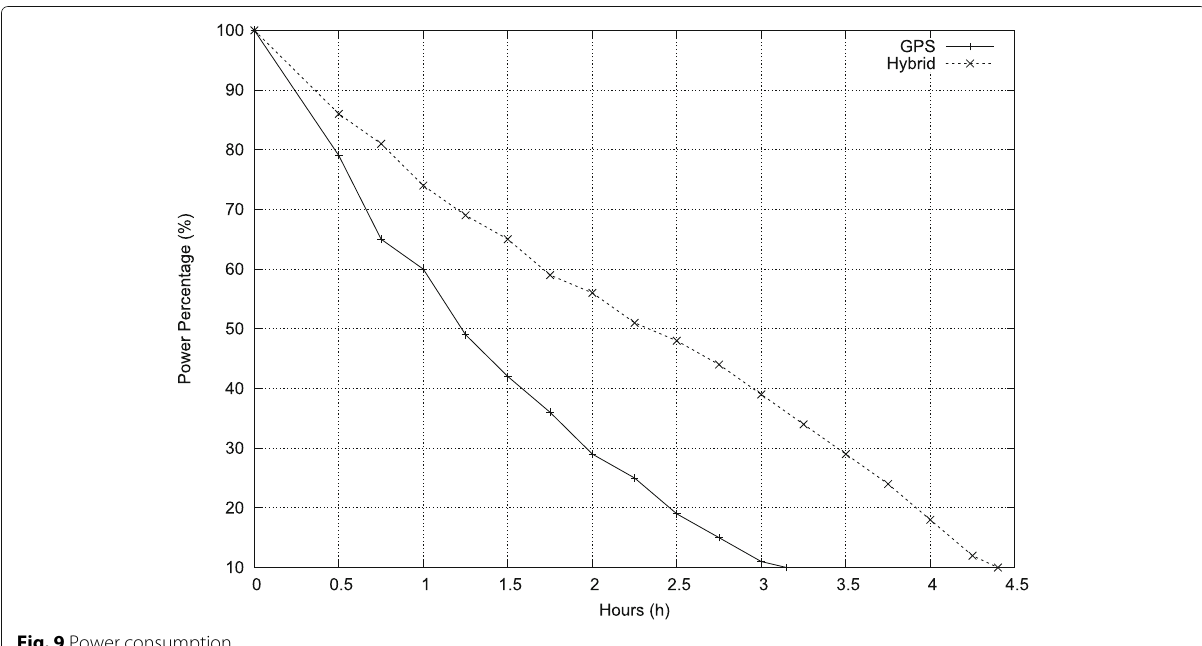
Fig. 9 Power consumption